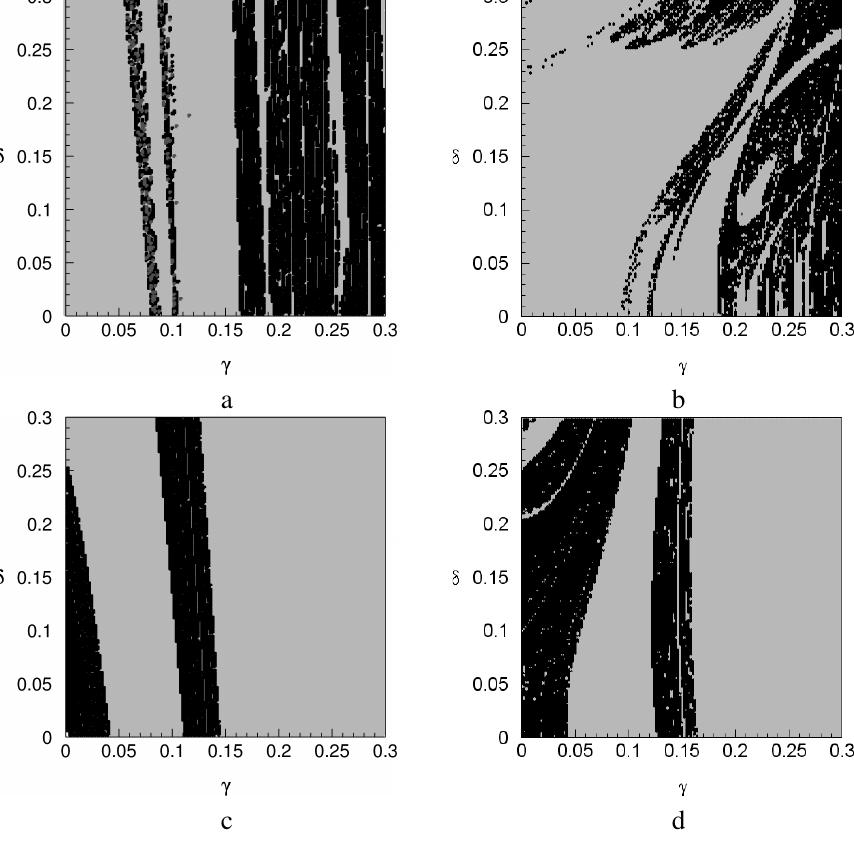
Fig. 2 Maps of dynamical